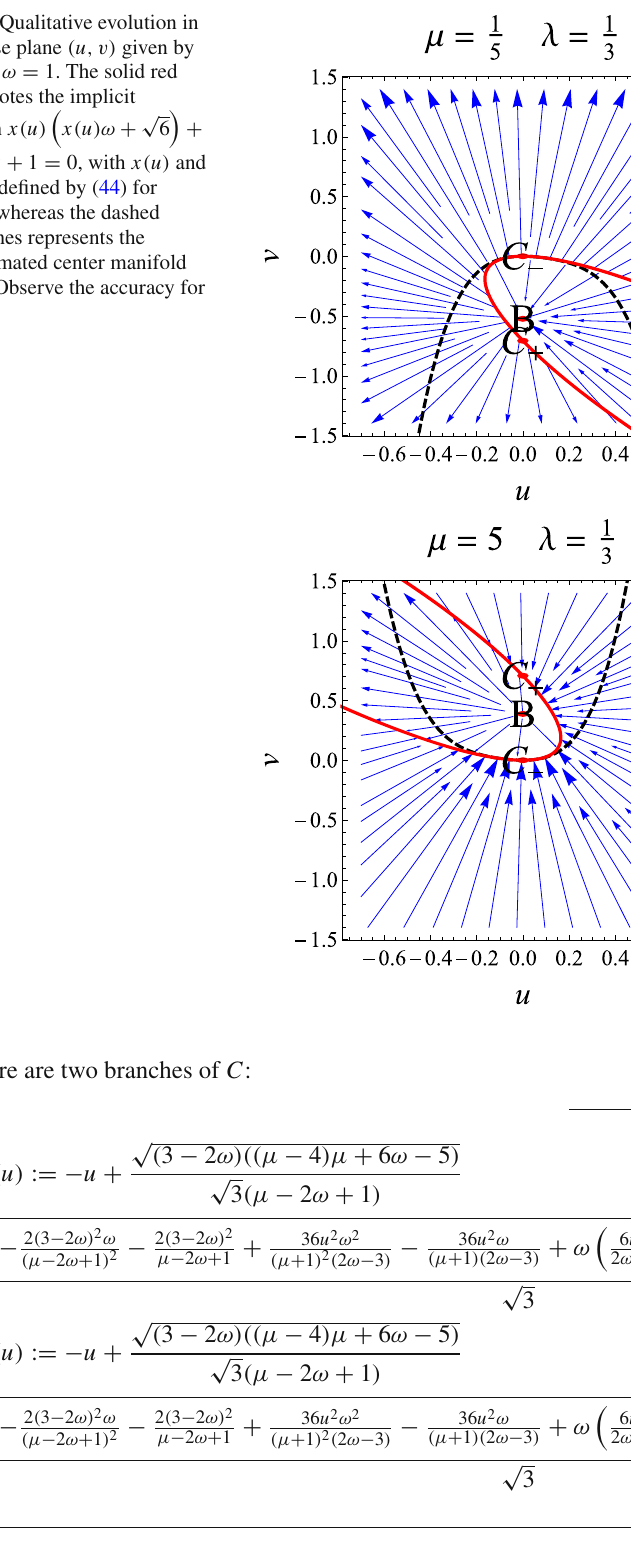
Fig. 5 Qualitative evolution in the phase plane ( u ,v) given by (45) for ω = 1. The solid red line denotes the implicit (cid:9) (cid:10) √ + x ( u )ω + function x ( u ) 6 y ( u ,v) 2 + 1 = 0, with x ( u ) and y ( u ,v) defined by (44) for ω = 1, whereas the dashed black lines represents the approximated center manifold of C + . Observe the accuracy for small